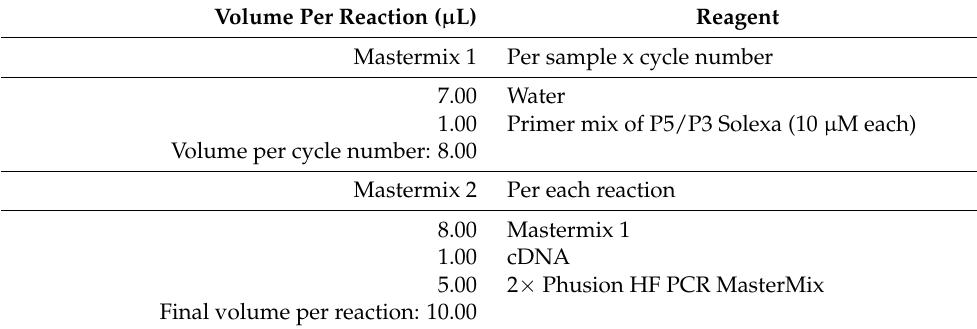
Table 12. PCR Mix for Second Amplification and Cycle Optimization.